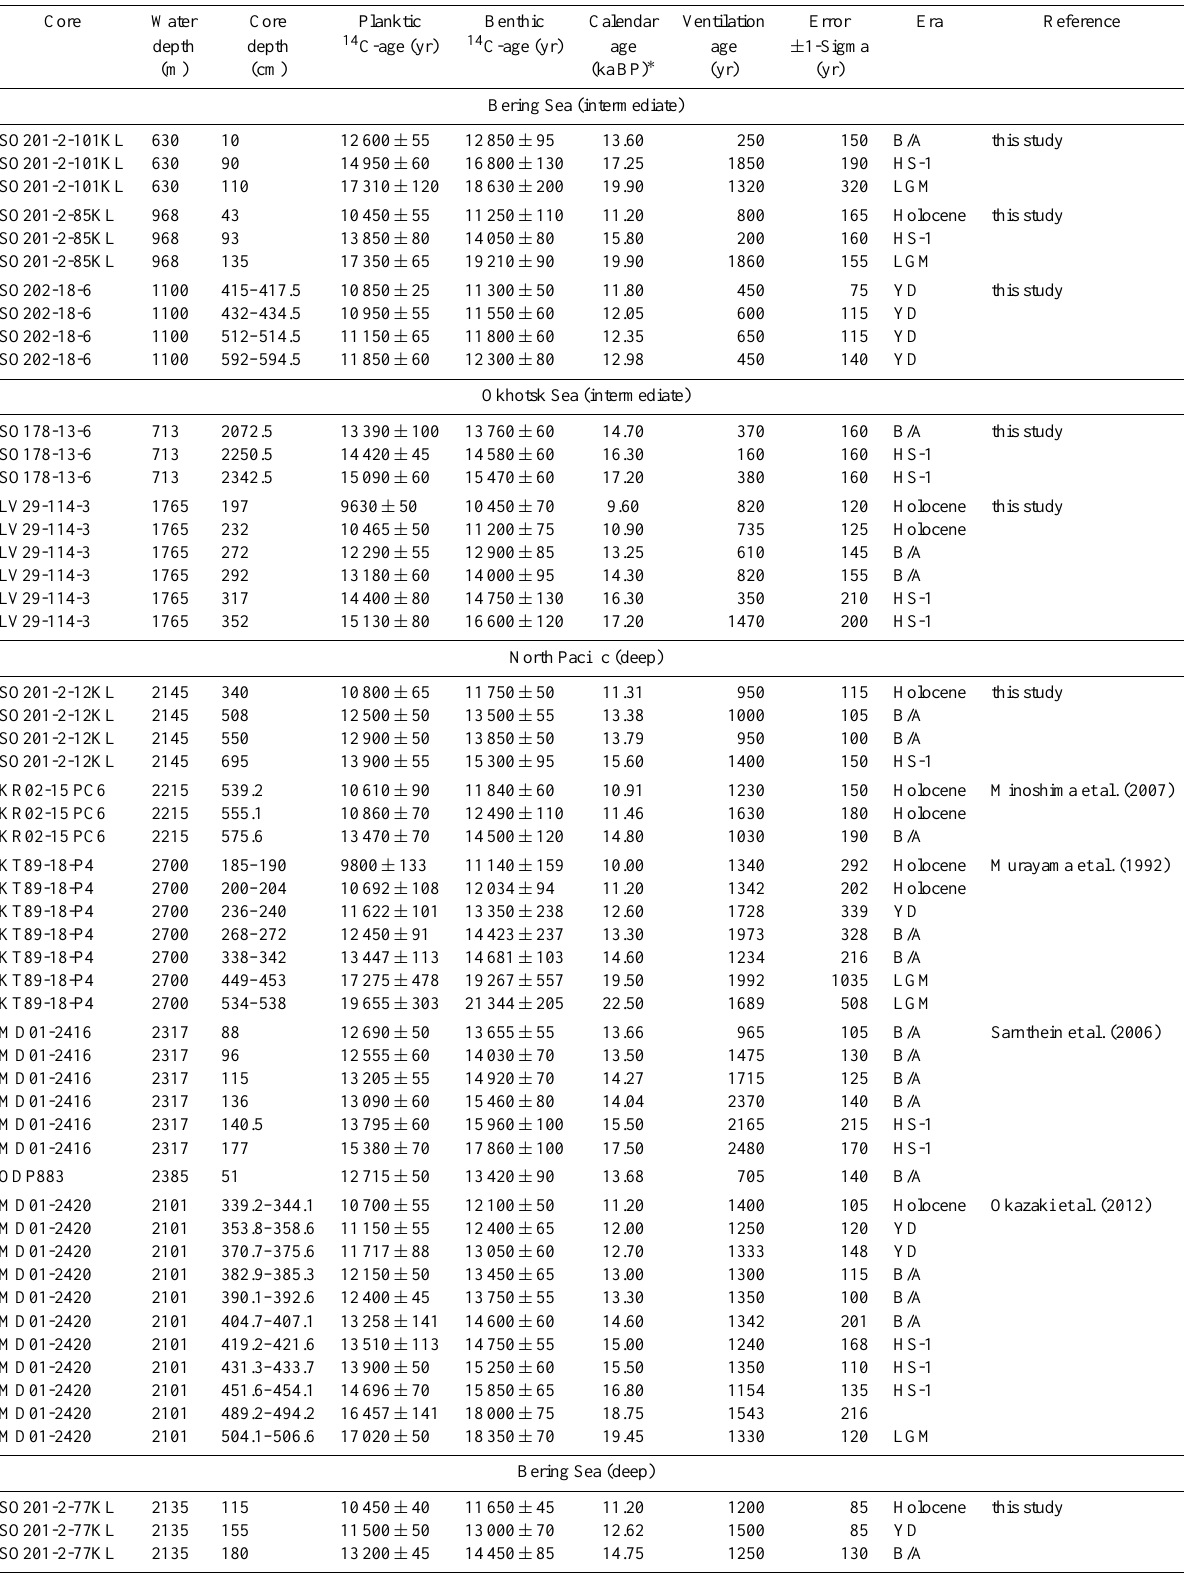
Table 3. Radiocarbon measurements on coeval benthic/planktic foraminiferas (ventilation ages) from NW-Pacific sediment cores. Ventilation ages are given in years and era is indicated by LGM, HS-1, YD, B/A and Holocene. Core Water Core Planktic Benthic Calendar Ventilation Error Era Reference depth depth 14 C-age (yr) 14 C-age